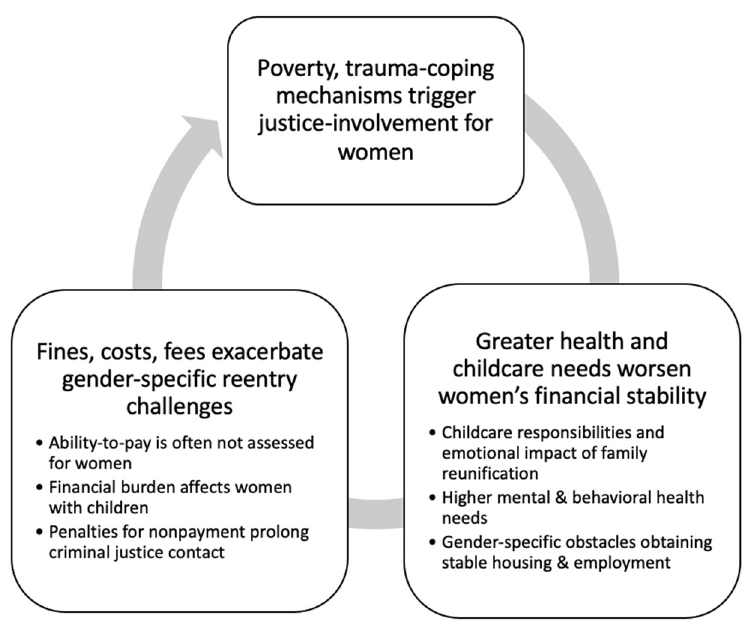
Figure 1. The cycle of financial instability and justice involvement for women based on interview